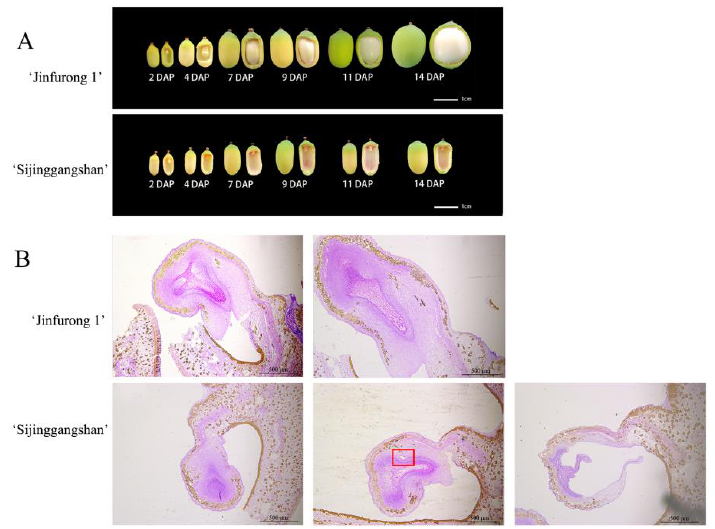
Figure 1. Embryo Development of ‘Jinfurong 1’ and ‘Sijinggangshan’. ( A ) Ovule development process of ‘Jinfurong 1’ and ‘Sijinggangshan’ after artificial self-pollination. ( B ) The anatomy of embryonic development of ‘Jinfurong 1’ and ‘Sijinggangshan’ DAP days after pollination.